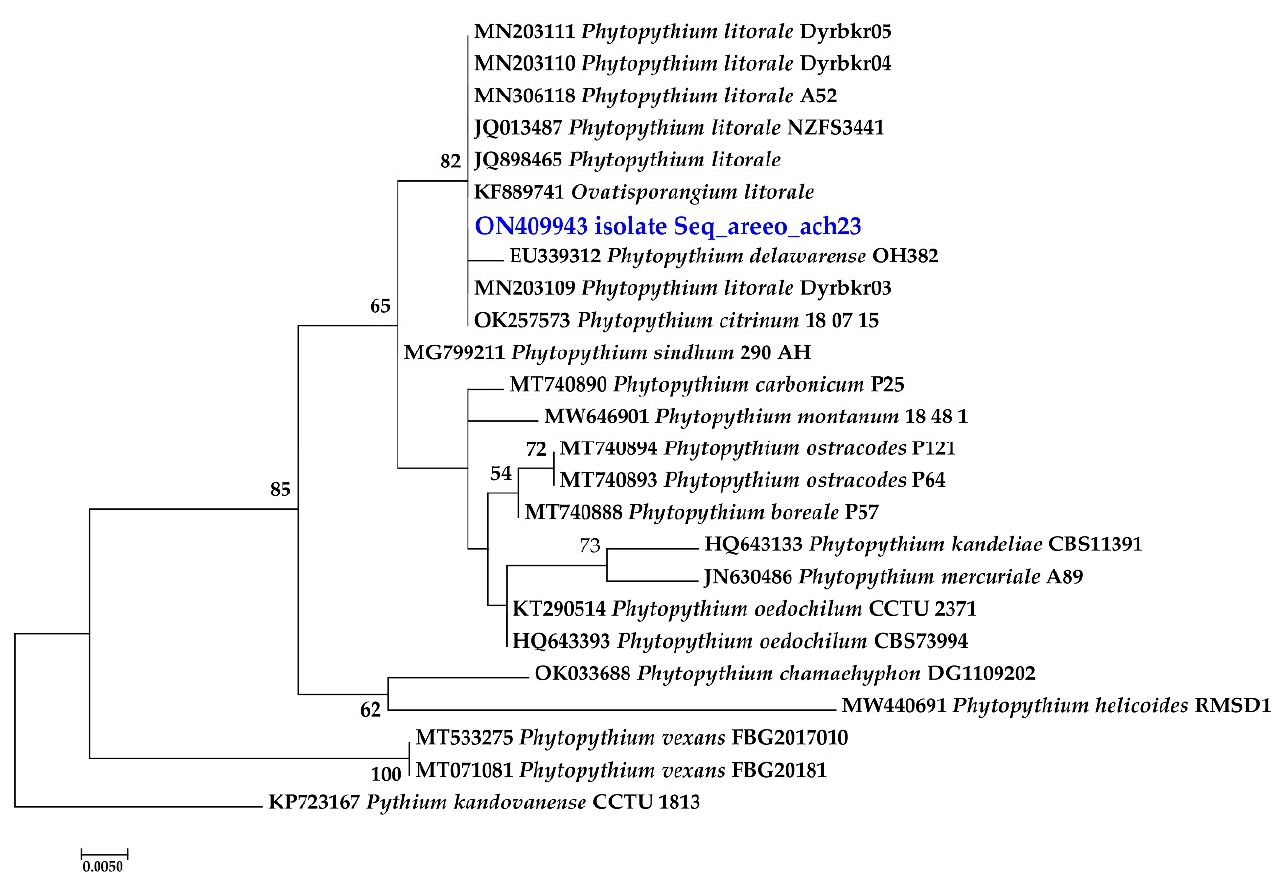
Figure 2. Phylogenetic position of Seq_areeo_ach23 isolate (accession number: ON409943) among other Phytopythium species based on maximum likelihood analysis of ITS-rDNA sequences. Boot- strap values of more than 50% from 1000 replications are shown on respective branches. Pythium kandovanense (CCTU 1813) was used as outgroup.